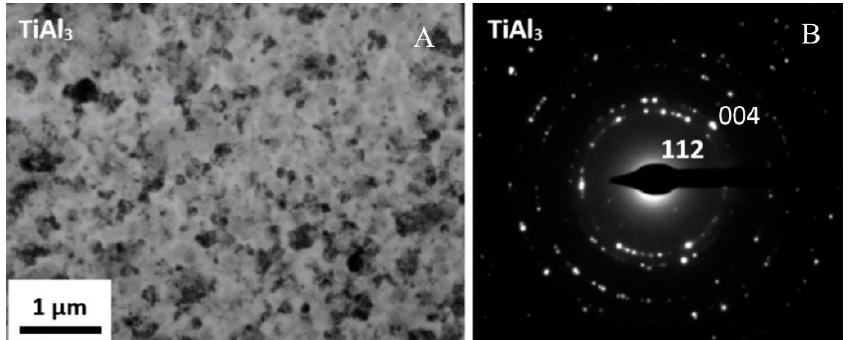
Figure 18. TEM image of AA1050/Ti6Al4V joint microstructure in hot-rolled state ( A ), with selected area diffraction patterns (SAED) ( B ). TEM lamella position in Figure 17.